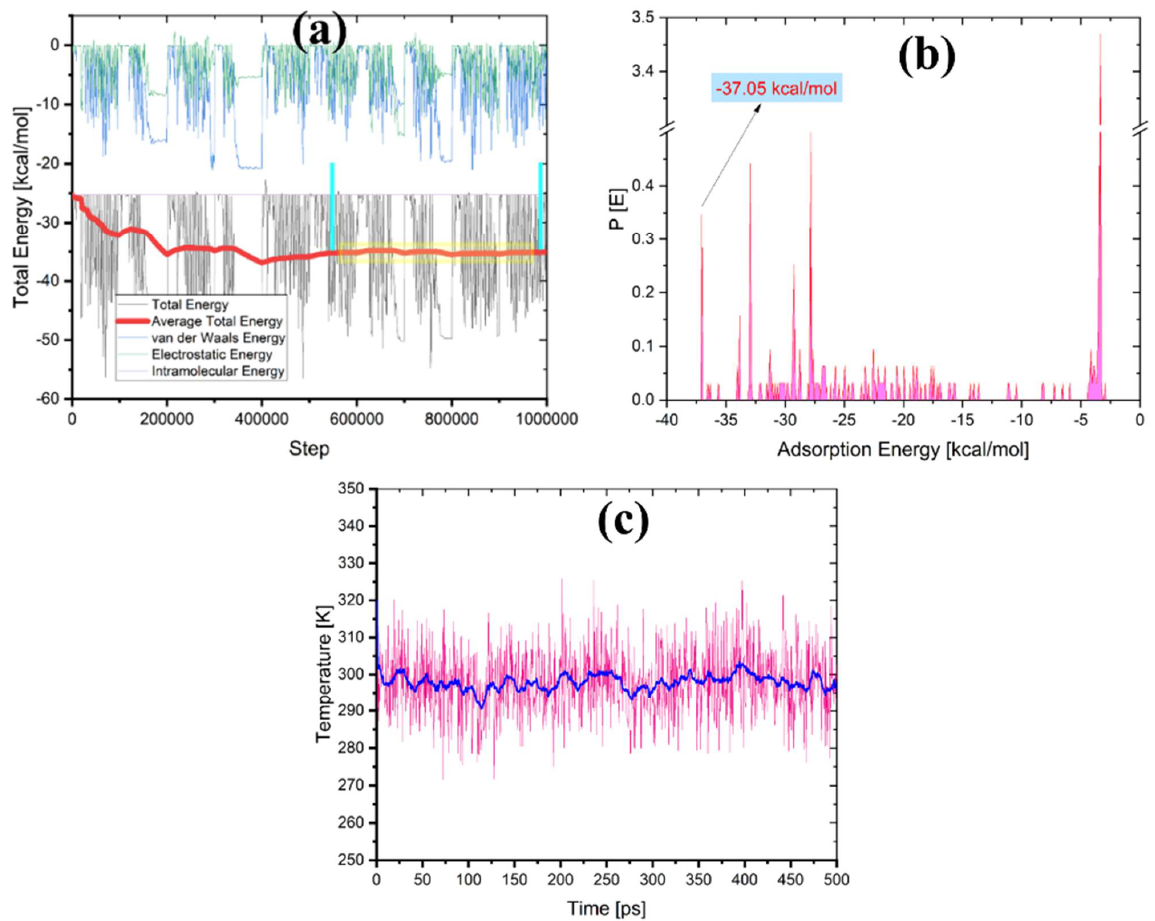
Figure 17. ( a ) Energy terms during the search for the MC pose of the lowest adsorption configurations for the difenoconazole molecule onto Cell-X surface, ( b ) Distribution of the adsorption energies for the difenoconazole molecule onto Cell-X surface gained via MC and ( c ) graph of temperature control from MD during the interaction of the difenoconazole molecule onto Cell-X surface.